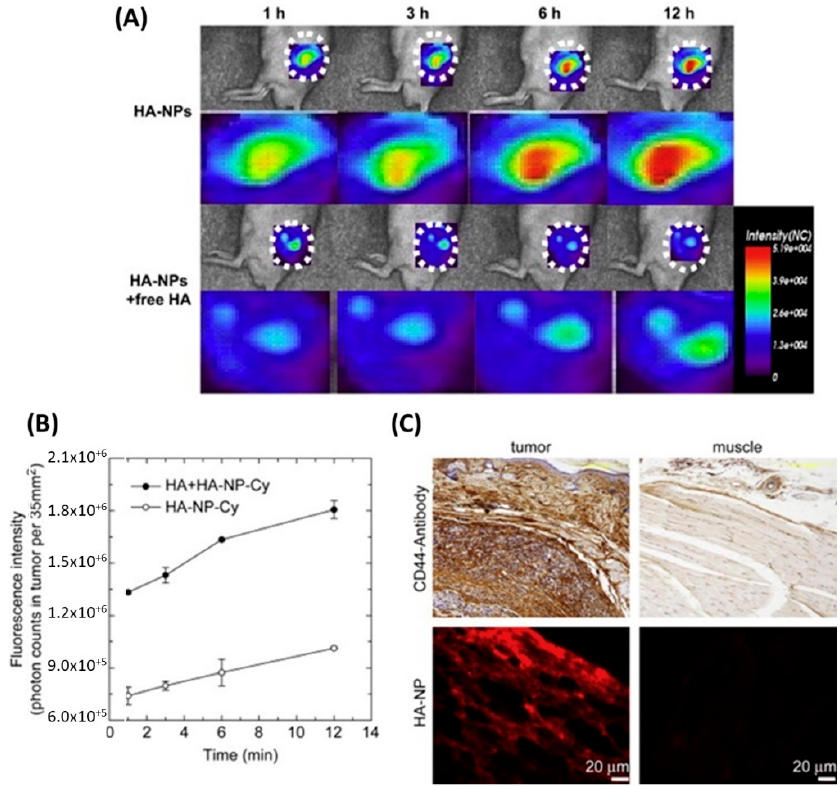
Figure 3. ( A ) In vivo fluorescence images of self-assembled HA-5- β CA nanoparticles and ( B ) their quantification in tumor-bearing mice with and without pre-injection of free-HA. ( C ) Magnified images of tumor and muscle tissues. Adapted with permission from Ref. [66]. 2009, Elsevier Ltd.